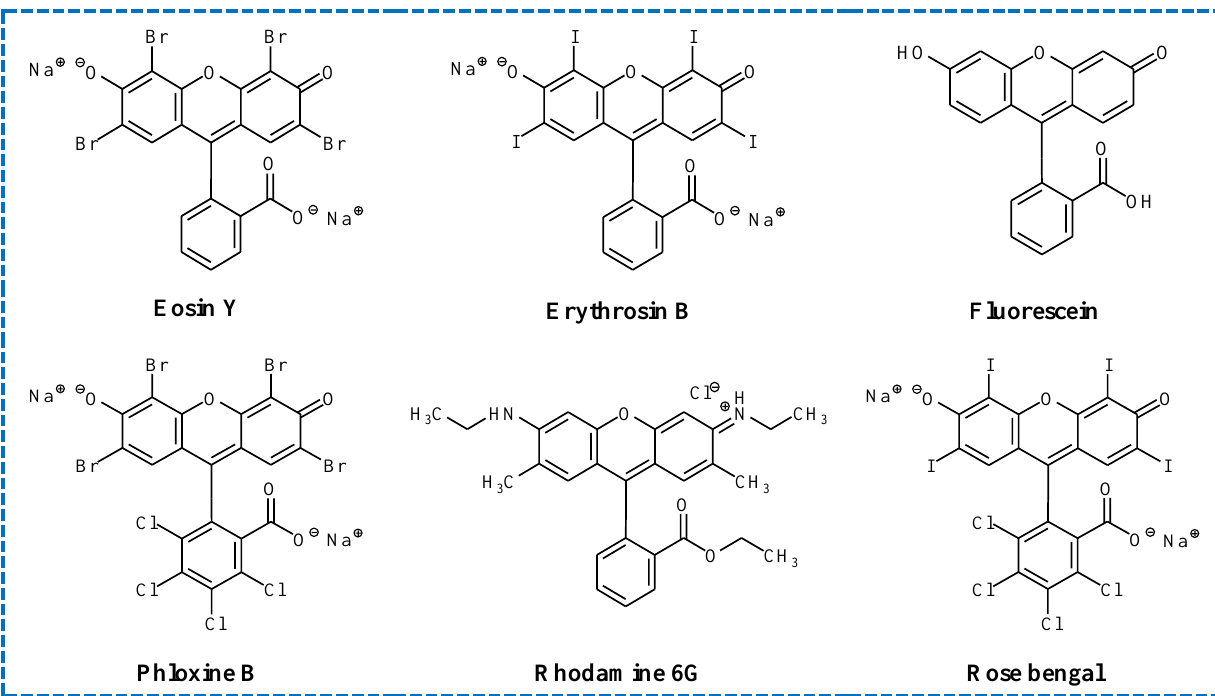
Figure 9. Chemical structures of organic chromophores used as photoactivators for PET-RAFT processes [92,95,96].